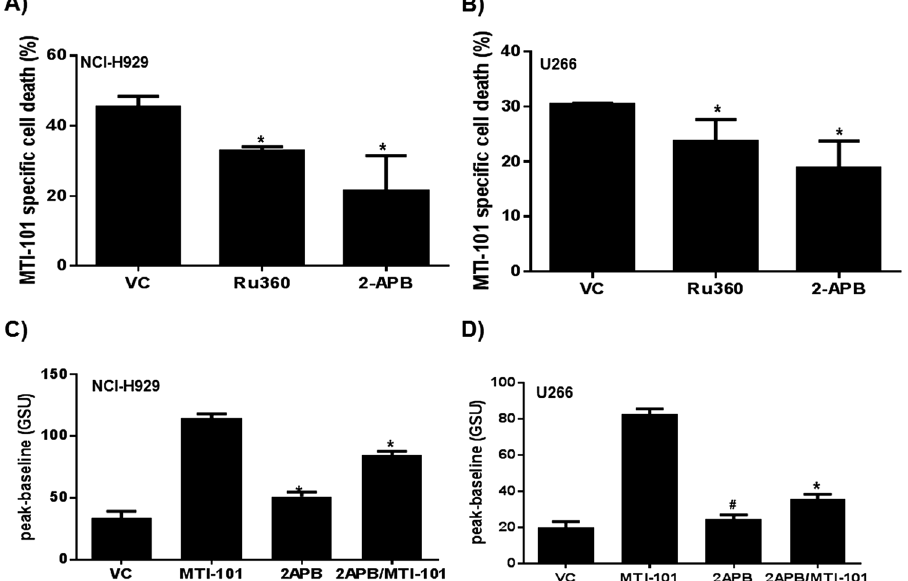
Figure 3. Blocking Ca 2 + store operated calcium channels or inhibiting Ca 2 + entry into mitochondria impairs MTI-101 induced cell death. ( A ) NCI-H929 and ( B ) U266 MM cells were pretreated with 50 μ M-APB and 5 μ M Ru360 for 30 min or vehicle control (VC). After 30 min cells were treated with 10 or 20 μ M of MTI-101, respectively, for 2 hr. MTI-101 specific cell death was measured by FACS analysis. Shown is a representative experiment performed in triplicate. ( C ) NCI-H929 and ( D ) U266 MM cells were pretreated with 50 µ M of 2-APB followed by treatment with 10 or 20 µ M of MTI-101, respectively. Ca 2 + levels were measured by fluo4 AM. The Y-axis is depicted as gray scale units (GSU or pixel